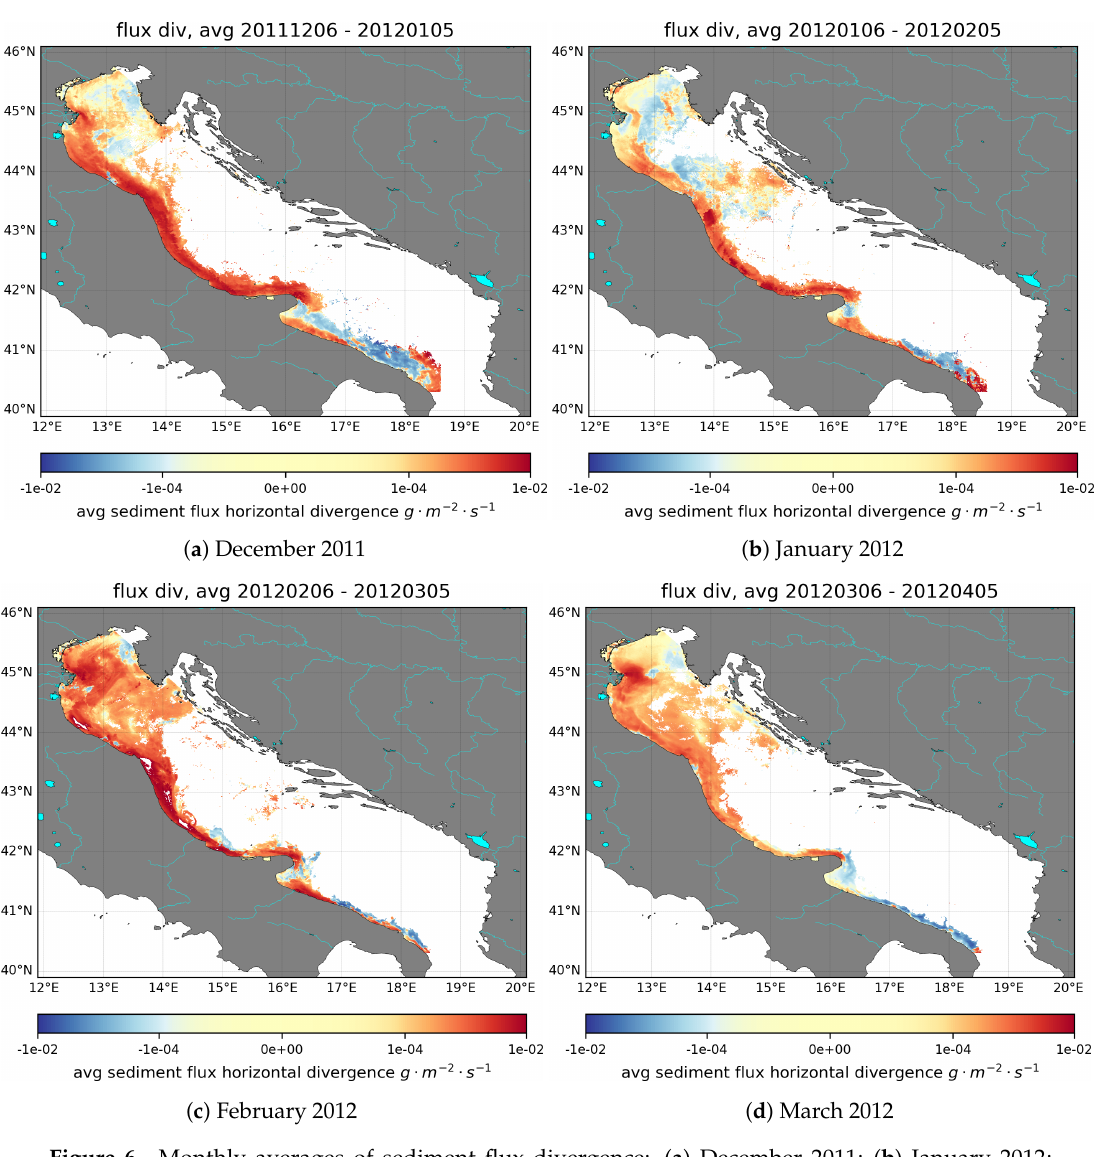
Figure 6. Monthly averages of sediment flux divergence: ( a ) December 2011; ( b ) January 2012; ( c ) February 2012; and ( d ) March